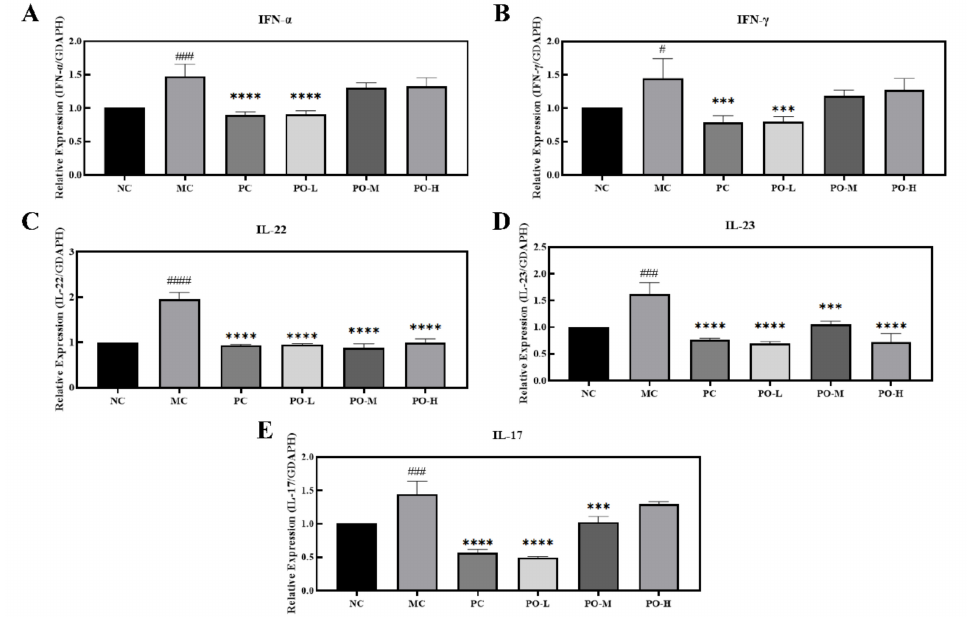
Figure 3. PO down-regulated the mRNA levels of IFN- α , IFN- γ , IL-22, IL-23, and IL-17 in the skin of BALB/c mice. ( A ) mRNA level of IFN- α . ( B ) mRNA level of IFN- γ . ( C ) mRNA level of IL-22. ( D ) mRNA level of IL-23. ( E ) mRNA level of IL-17. The internal reference for all target mRNAs is GADPH. Data are shown as mean ± SEM (n = 8), # p < 0.05, ### p < 0.001, #### p < 0.0001 vs. NC group, *** p < 0.001, **** p < 0.0001 vs. MC